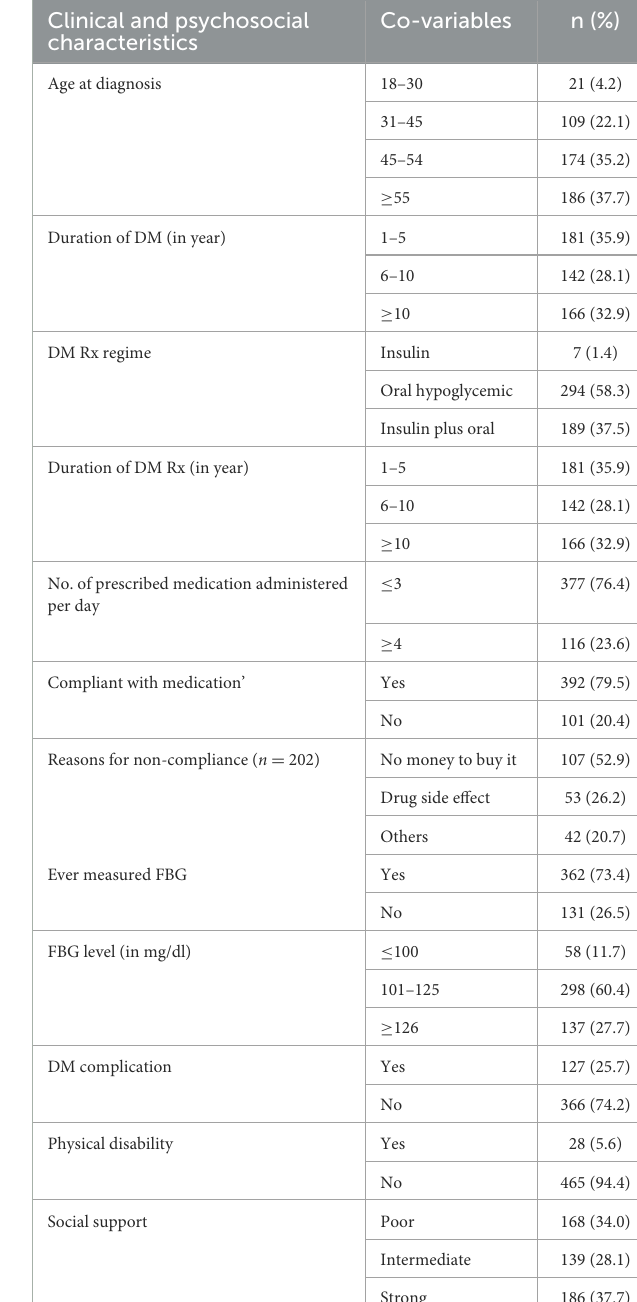
TABLE 1 Socio-demographic characteristics of patients with diabetes mellitus attending the outpatient department of SINA Clinics